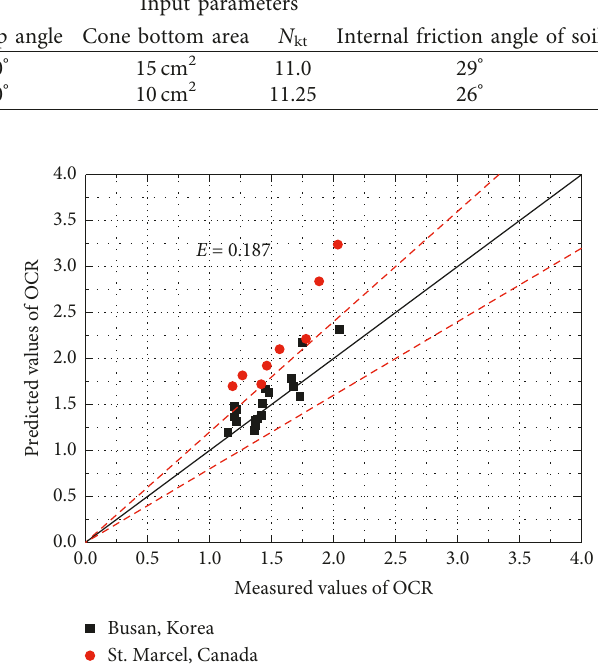
Figure 8: Comparison of the measured values and predicted values of the OCR using Wayne’s method.